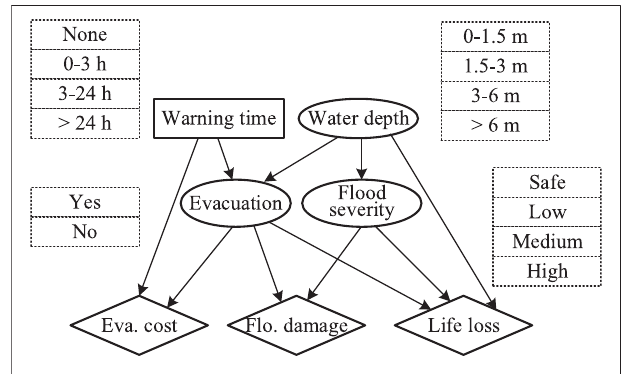
FIGURE 1 | An example of Influence Diagram: eva. (cid:2) evacuation and fl o. (cid:2) fl ood.